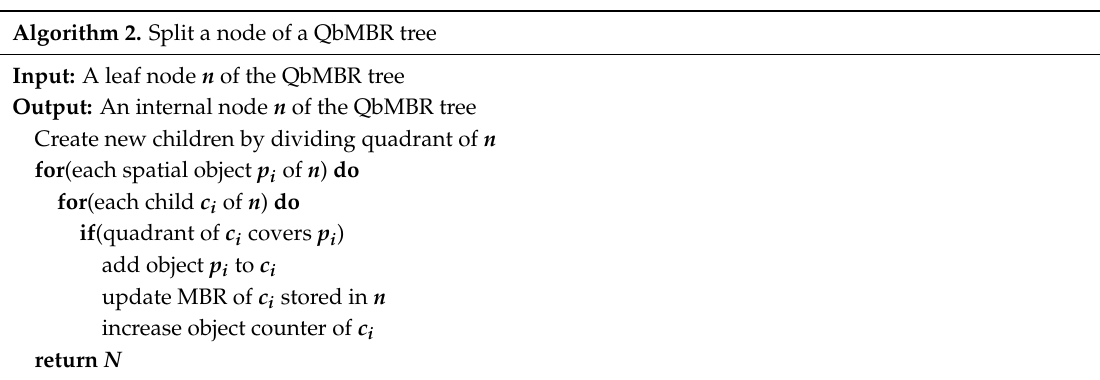
Algorithm 2. Split a node of a QbMBR